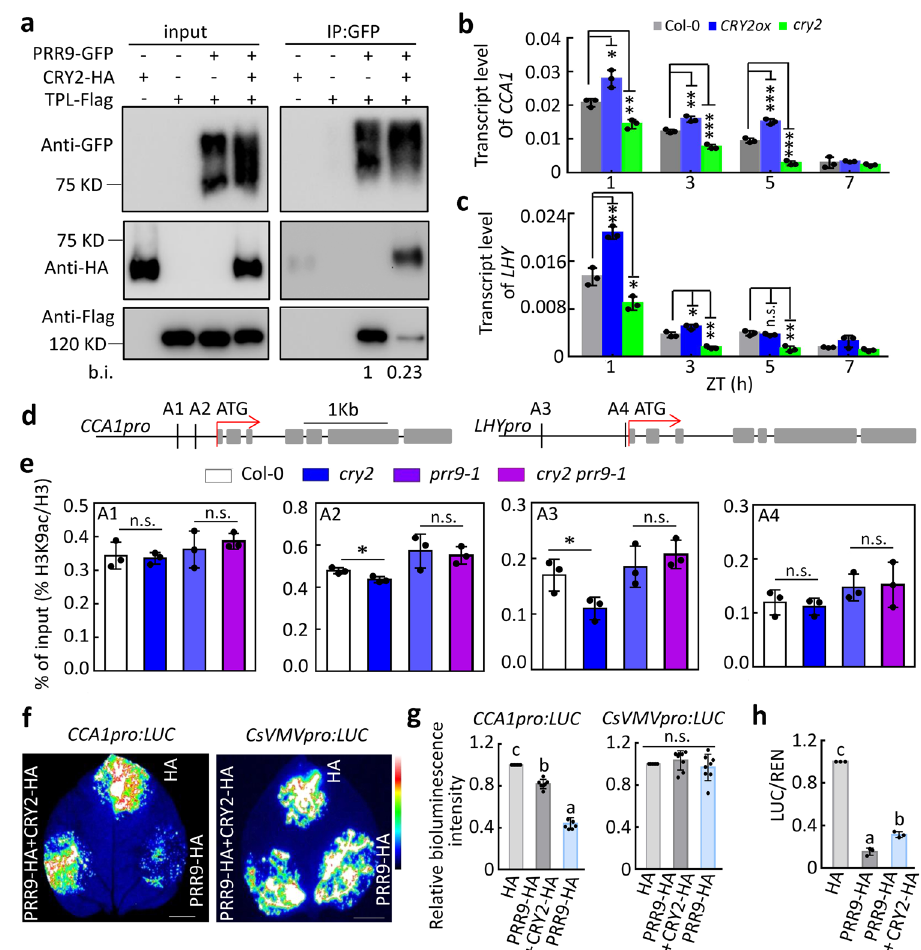
Fig. 2 | CRY2 inhibits the transcriptional repressive activity of PRR9. a Co-IP assay showing CRY2 interfered with the interaction of PRR9 with TPL. The IPed (PRR9-GFP)andco-IPedsignals(TPLandCRY2)weredetectedbyimmunoblotwith GFP, Flag and HA antibodies, respectively. b.i. stands for band intensity. b , c Temporal expression level of CCA1 ( b ) and LHY ( c ) in Col-0, 35S:GFP-CRY2 ( CRY2ox ), and cry2 mutant by RT-qPCR. Seedlings were grown for 10 days in LD condition and then exposed to2.5 μ molm − 2 s − 1 blue light for indicatedtime points. Dataweremean±s.d., n =3,technicalrepeats.*** p <0.001,** p <0.01,* p <0.05,n.s. means no signi fi cant difference compared to Col-0 by two-tailed student ’ s t -test. Similar results were observed from three independent repeats. d Simpli fi ed sche- maticrepresenting promoterregions andgene structures of CCA1 and LHY . A1and A2 denote amplicon regions − 516 to − 303 and − 313 to − 90 on CCA1 promoter, A3 and A4 denote amplicon regions − 1075 to − 931 and − 44 to +192 on LHY promoter. e Relative H3K9ac/H3 levelsin Col-0, cry2-1 , prr9-1 , and cry2-1 prr9-1 . Two weeks of seedlings entrained inLD cycles were harvested at ZT4for ChIP assay with H3K9ac or H3 antibody. The enrichment of amplicons was analyzed by ChIP-qPCR.